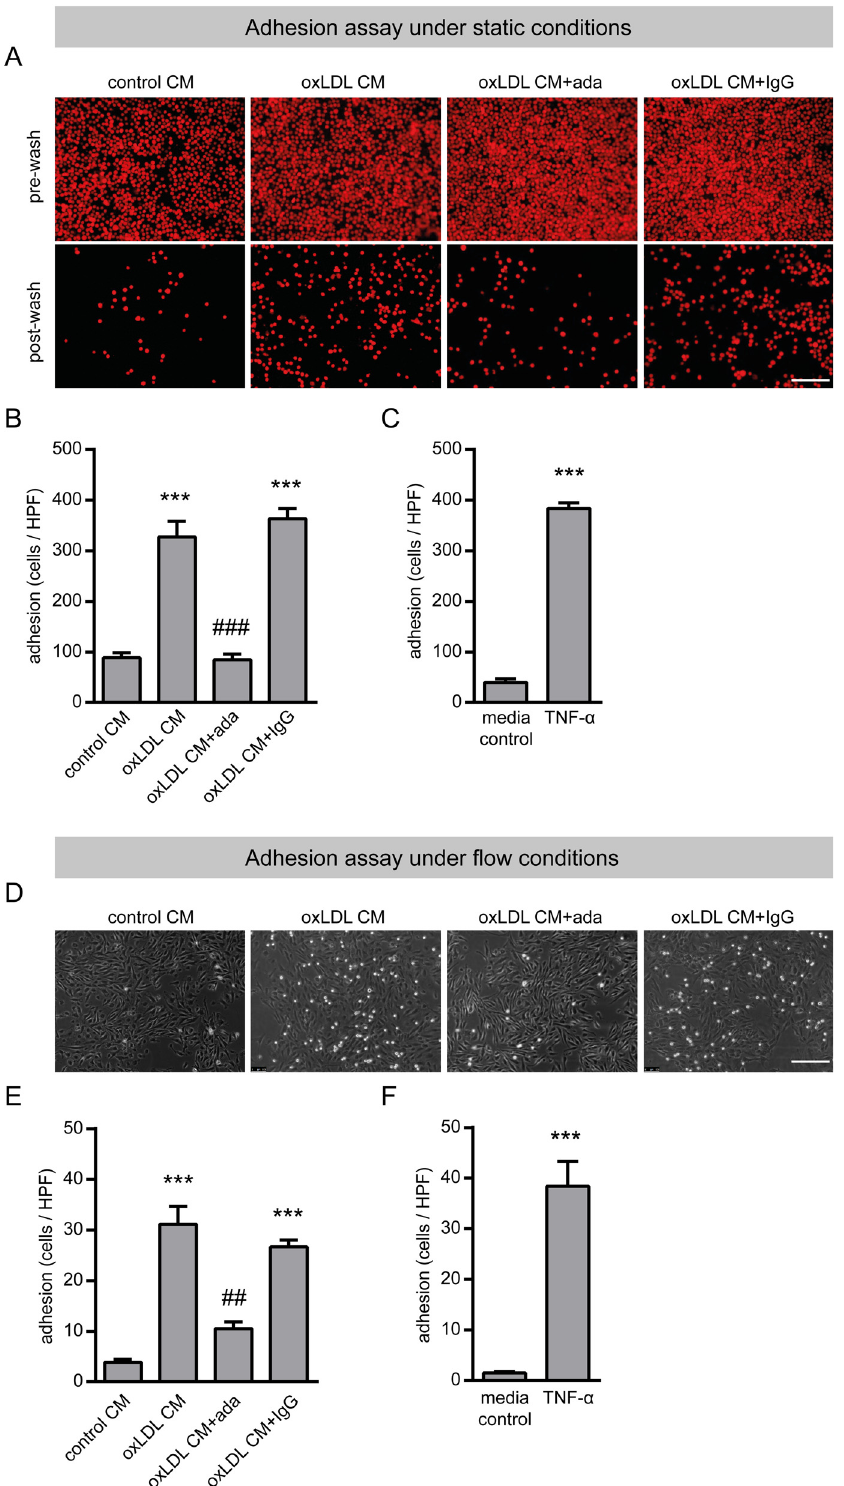
Fig 4. Effect of TNF- α inhibition with adalimumab on adhesion of THP-1 monocytes to endothelial cells. Adhesion assay under static conditions. (A) Fluorescence images depicting CellTracker green-labelled THP-1 monocytes on a HUVECs monolayer after incubation with conditioned media from oxLDL-stimulated